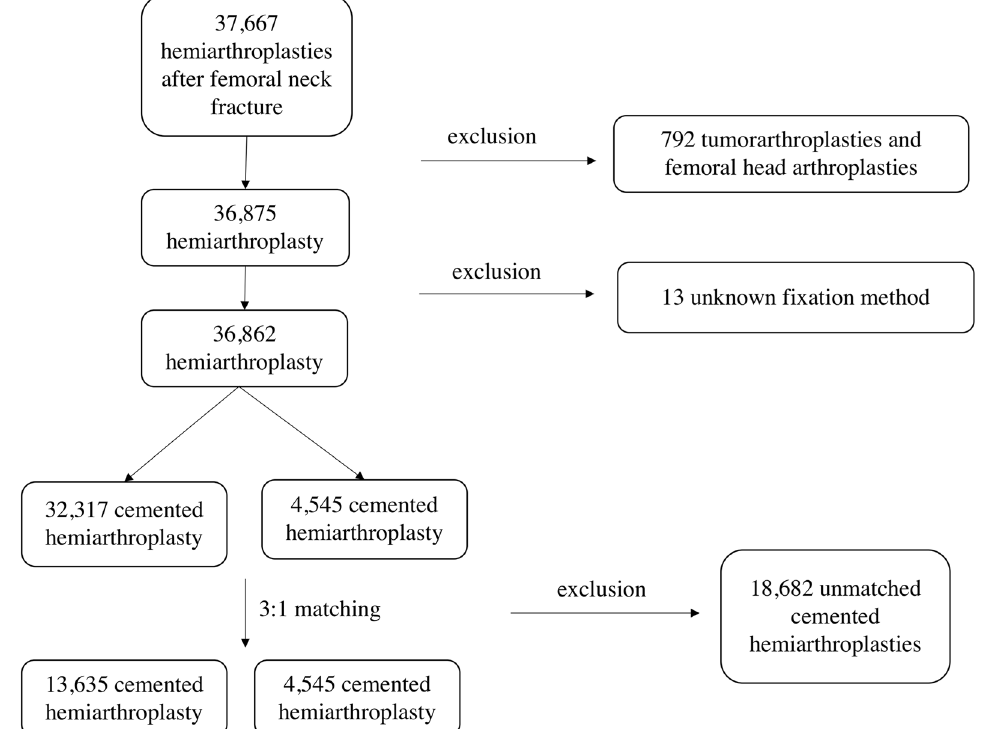
Fig. 1 Flow-chart of the study population with patient inclusion and exclusion